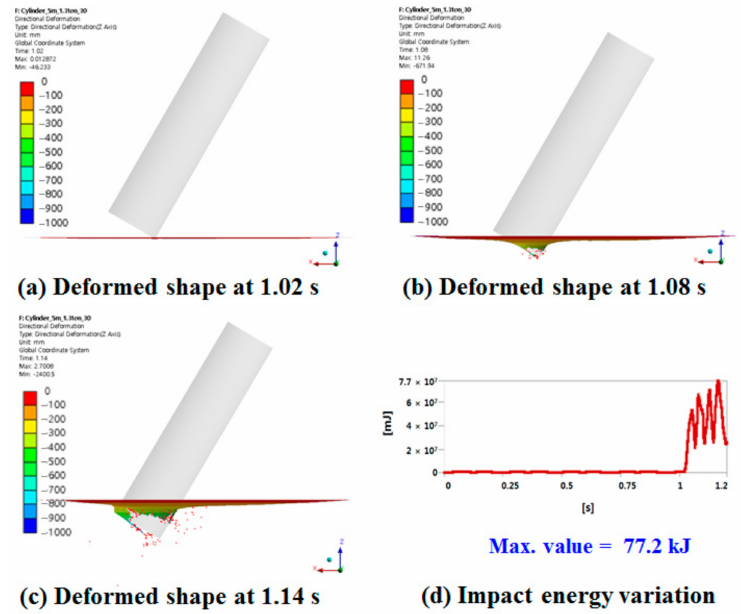
Figure 25. Simulation results (case 2, 30 ◦